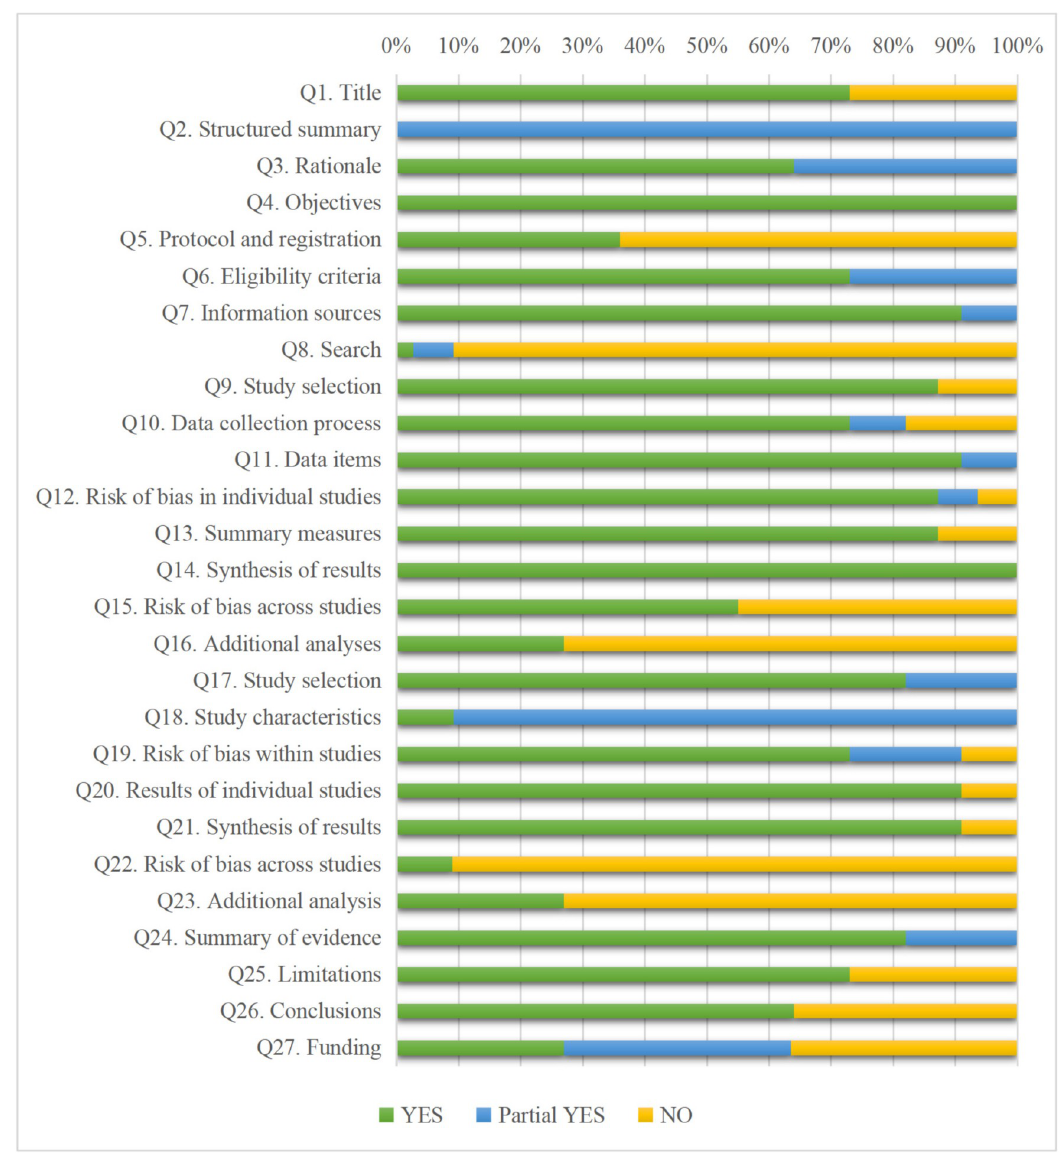
Fig 2. PRISMA score results for each